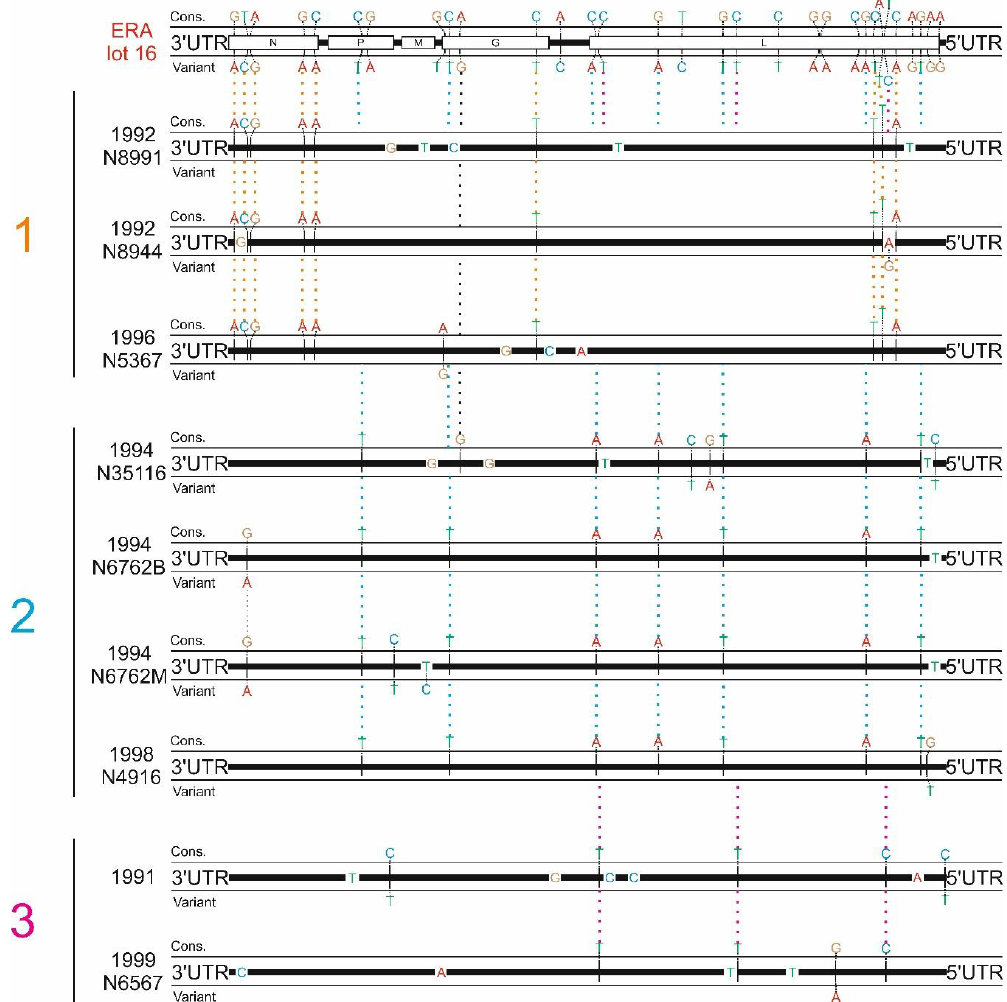
Figure 2. Schematic illustration of all variants found for the ERA vaccine-induced rabies cases as well as nucleotide exchanges between viruses from vaccine-induced rabies cases and the ERA-BHK21 vaccine virus strain. Colored dotted lines display differences at the consensus level for viruses from vaccine-induced rabies cases that derived from selected combinations of single nucleotide variants (SNVs) found in the progenitor ERA-BHK21 vaccine virus (group 1–3; Table 4, for variant frequencies, see Table S7, Supplementary File). Nucleotide bases illustrated on the genome sequence represent spontaneous mutations found for viruses of vaccine-induced rabies cases. Each of these three groups were characterized by a unique set of differences at the consensus level (Table 4). The only exception was the sample C/CAN/1994N35116 which lacked one difference (position 3587, Table S7) and had one additional difference in close proximity that cannot be found in any of the other samples (position 3734, Table S7).